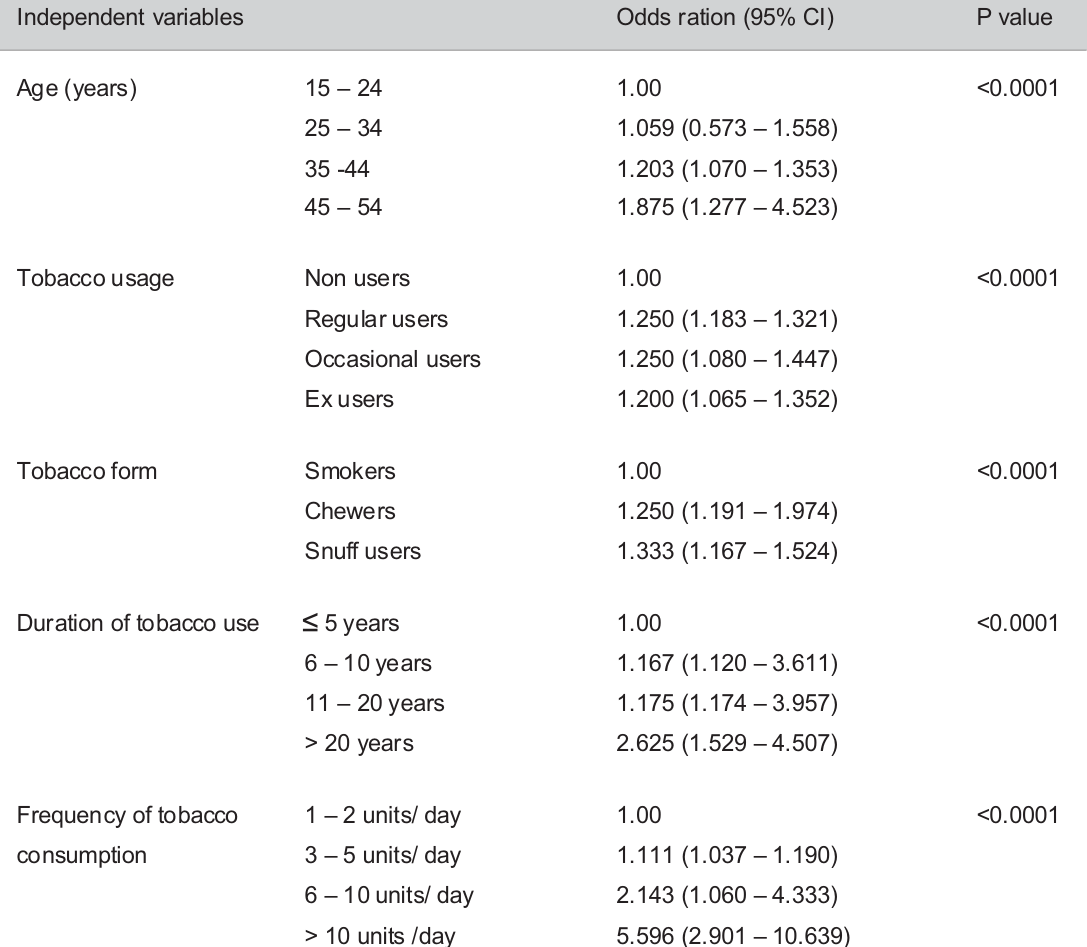
Table 6 - Logistic Regression analysis with CPI as dependent variable (absence Vs Presence periodontal pockets) and age, users of tobacco, form, duration and frequency of tobacco use as independent